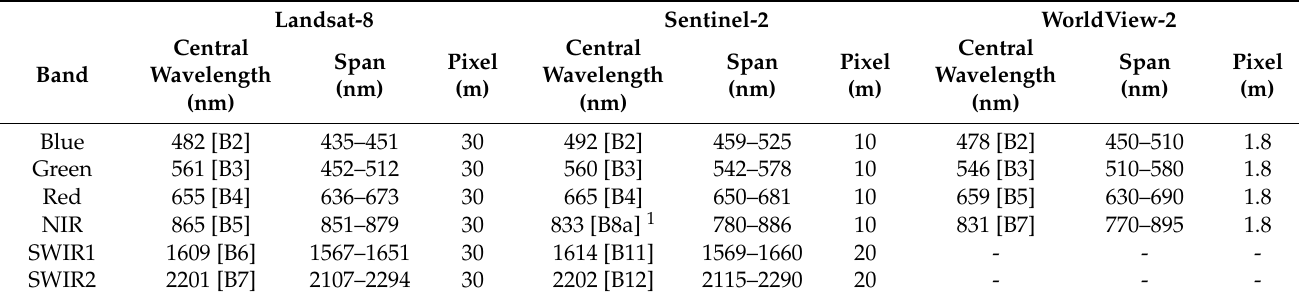
Table 1. Satellite information: central bands, bandwidth span, and pixel size (spatial resolution). NIR is near-infrared and SWIR is short-wave